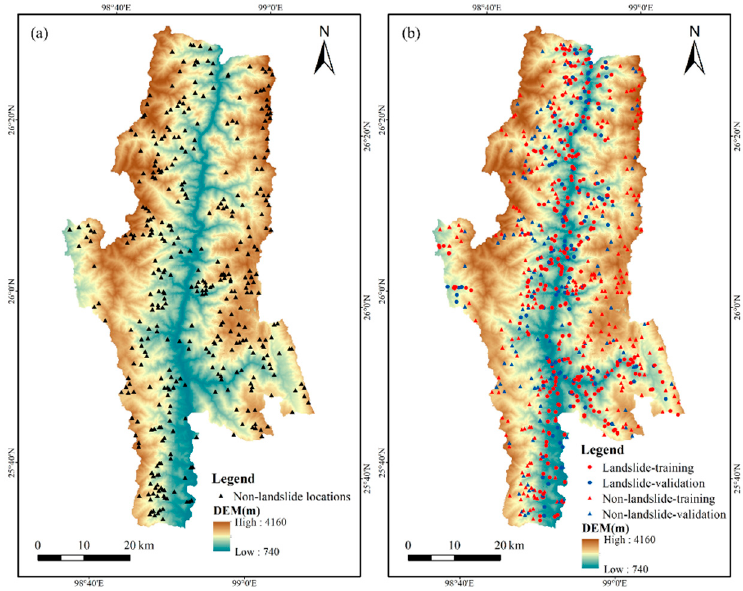
Figure 4. ( a ) Locations of the selected non-landslide; ( b ) Distributions of the training dataset and validation dataset. DEM: digital elevation model.